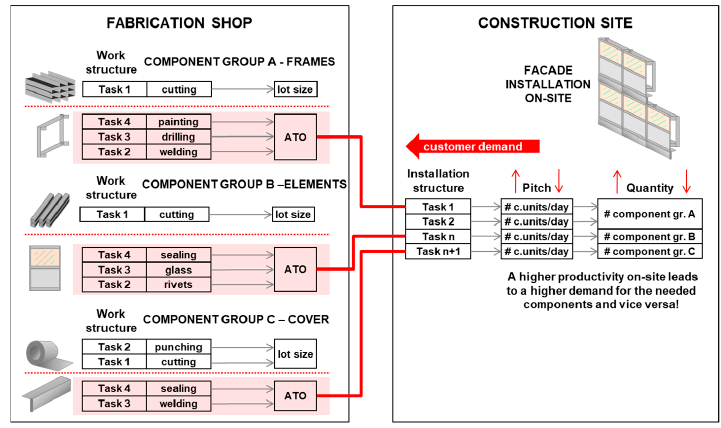
Figure 5. Pitching approach for on-demand production and supply (based on [55]).